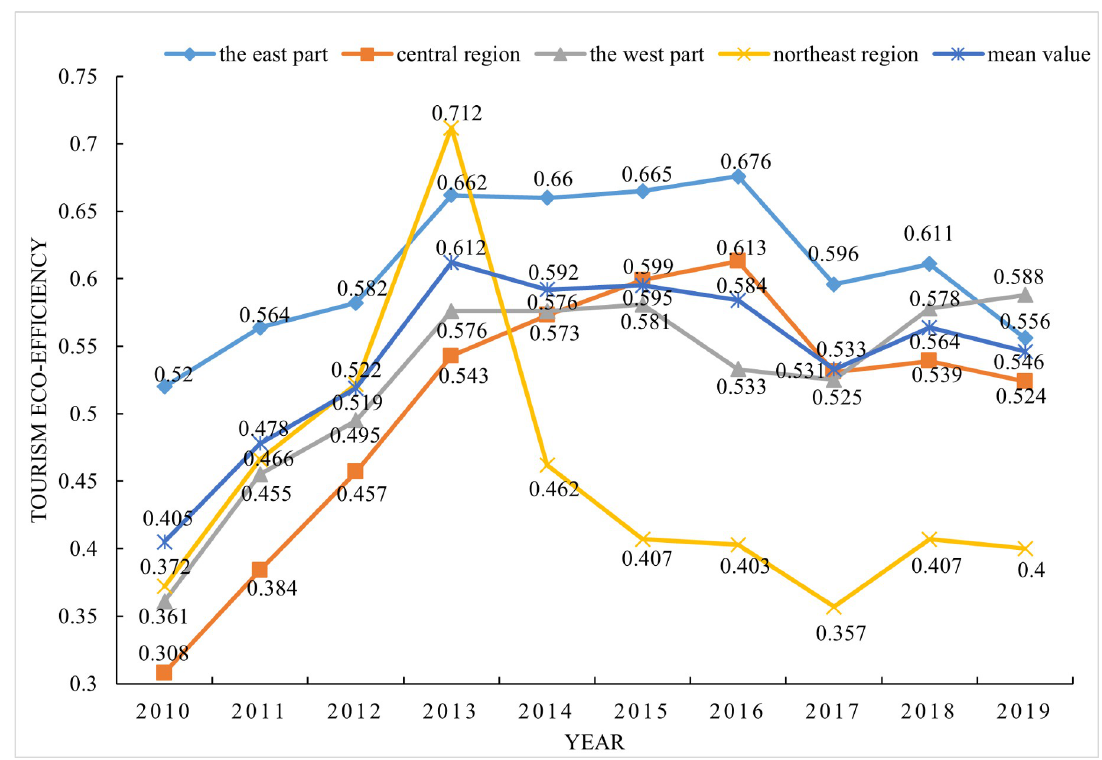
Fig 2. Eco-efficiency value of regional tourism in China from